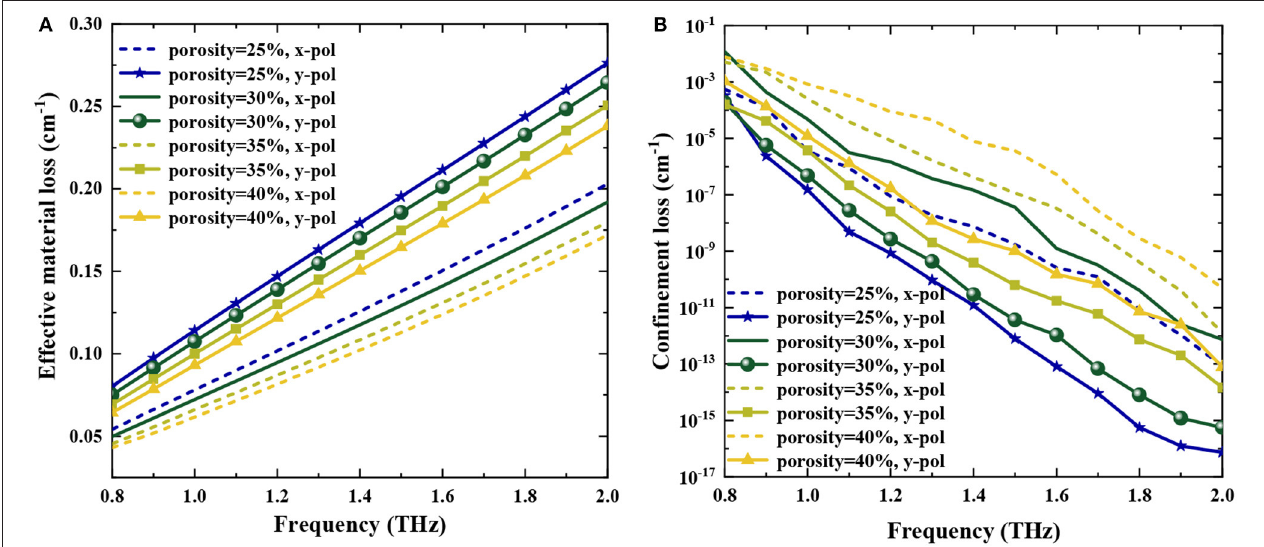
FIGURE 6 | (A) EML and (B) confinement loss vs. frequency for the proposed THz-PCF at different core porosity and fixed D core = 378 µ m.